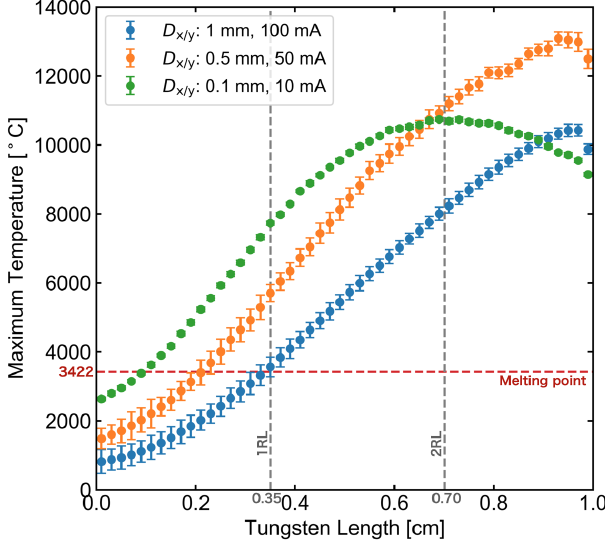
FIG. 18. Maximum temperature along the path of a positron beam in the cylindrical tungsten target. The beam profile and energy are respectively Gaussian and 4 GeV. D x=y refers to the diameter (FWHM) of the beam in the horizontal or vertical direction. The target has a length of 10 mm and diameter of 10 mm. The environment around the target is set to vacuum. The revolution frequency in the main ring is 100 kHz, and the beam current of 10 mA corresponds to approximately 6 . 24 × 10 11 positrons, for